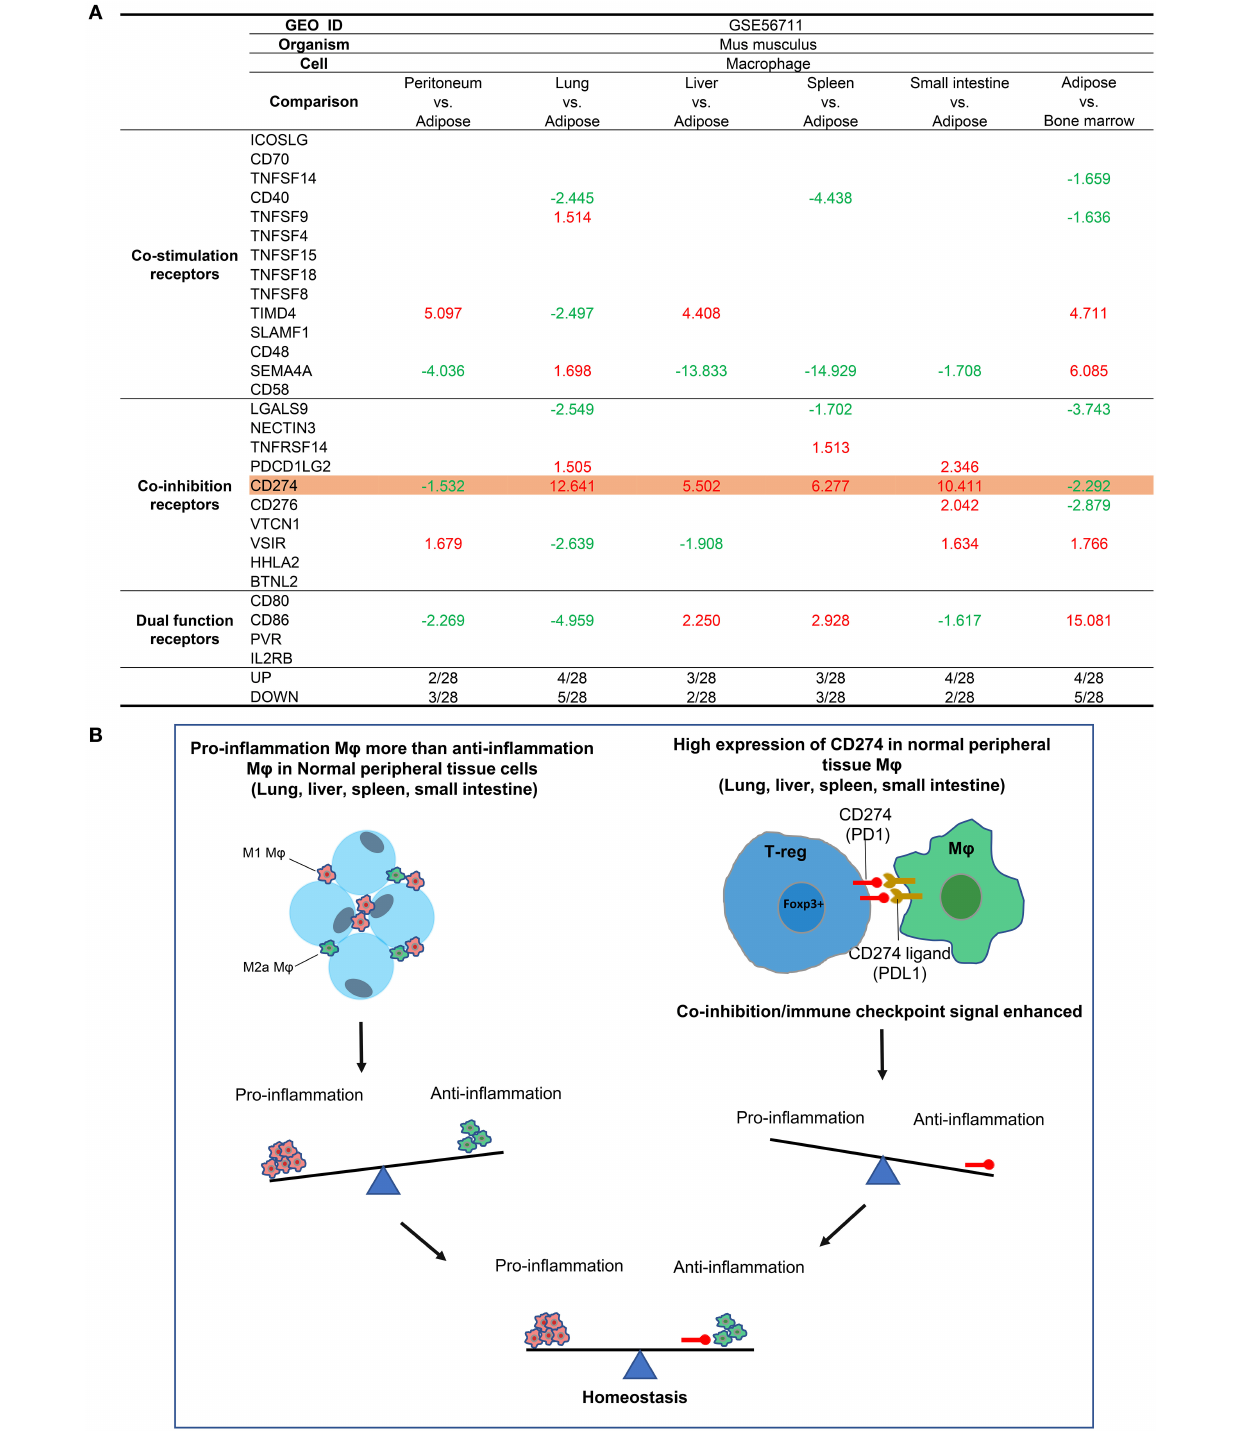
Frontiers in Immunology |